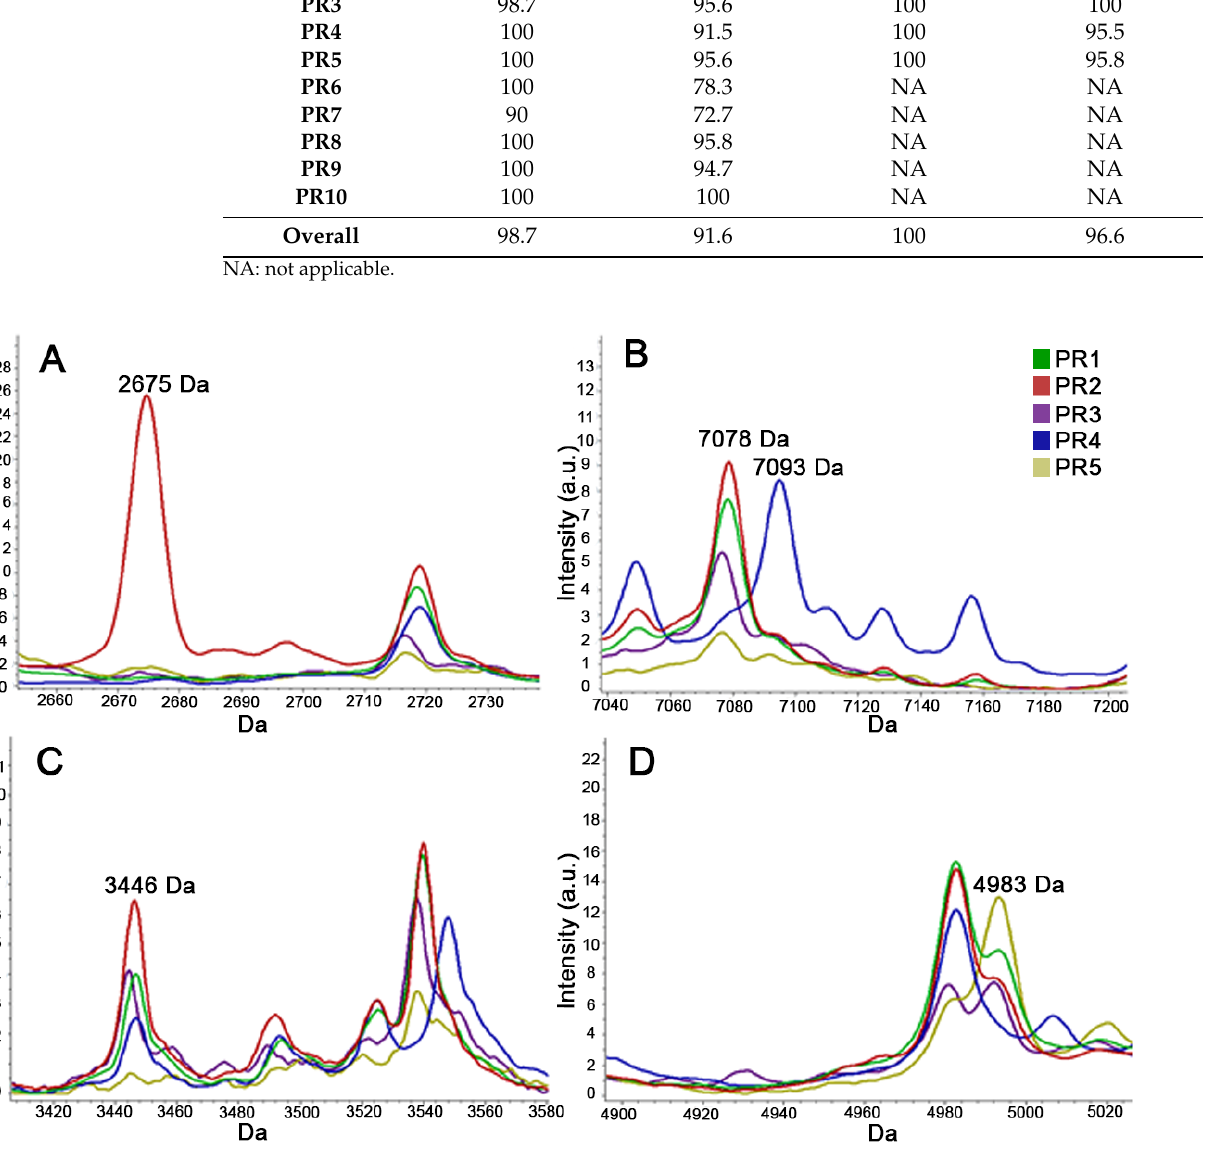
Figure 4. Examples of discriminating peaks able to differentiate the PR1–PR5 ribotypes. ( A ): peak of 2675 Dalton present only in ribotype PR2; ( B ): peaks of 7078 Dalton present in all ribotypes except PR4 and of 7093 Dalton present only in ribotype PR4; ( C ): peak of 3446 Dalton present in ribotypes PR1, PR2, PR3, and PR4; ( D ): peak of 4983 Dalton present in ribotypes PR1, PR3, and PR5. The spectra of the ribotypes PR1, PR2, PR3, PR4, and PR5 are shown in green, red, purple, blue, and yellow,